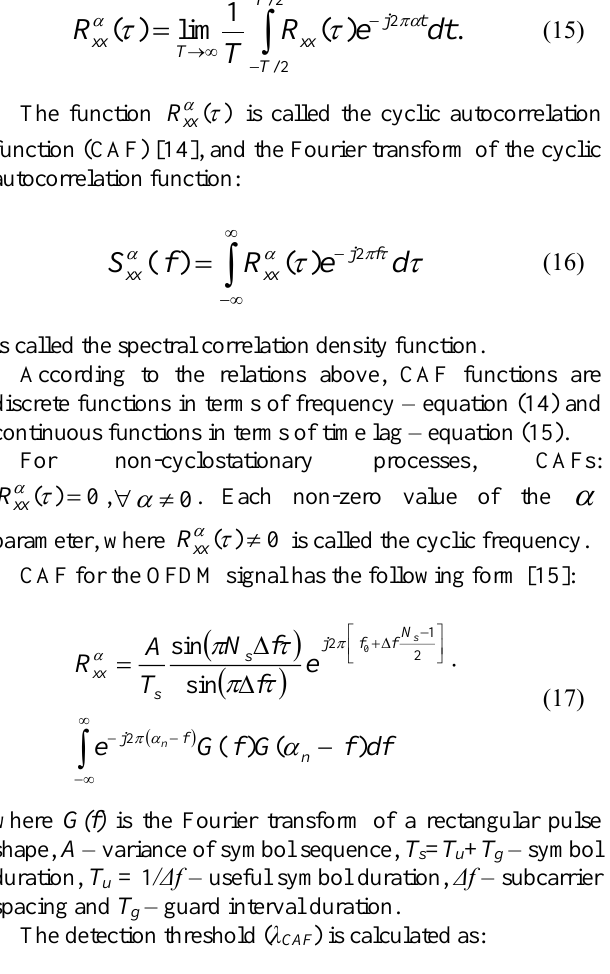
Table 1. Parameters of the licensed